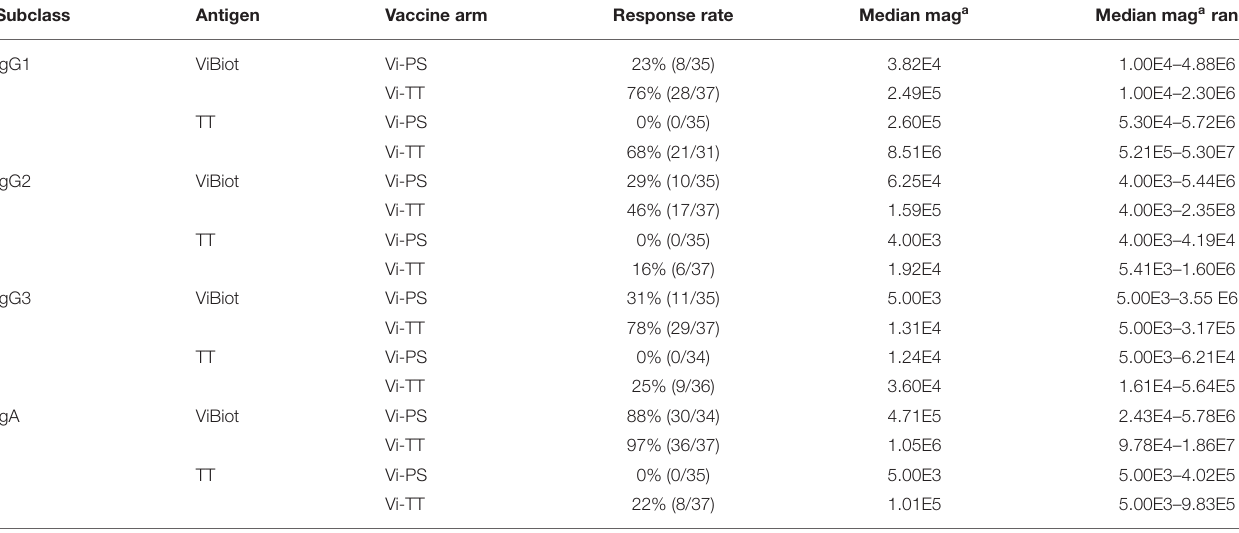
TABLE 1A | Antigen-specific magnitude by vaccine group at Day of challenge (D0).